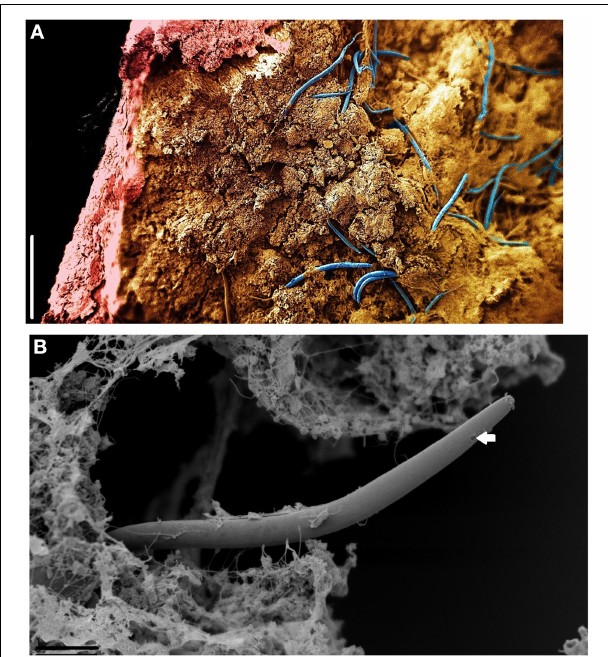
FIGURE 5 | SEM of Monhystrella parvella inside a CaCO 3 stalactite after longitudinal sections with a scalpel. (A) Composite image made of four images taken at different focal points and assembled using Adobe Photoshop. Nematodes (blue) reside in the amorph mass within the confines of the CaCO 3 outer stalactite wall (pink). (B) Detail of M. parvella , arrow highlights the fovea. Scale bars: (A,B) : 200 μ